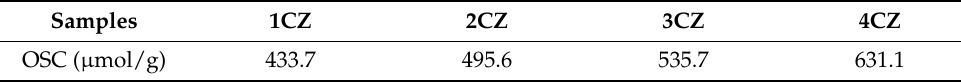
Table 5. OSC data for CZ nanoparticles.